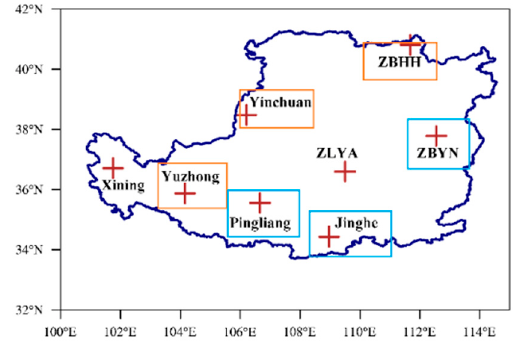
Figure 3. Locations of the eight stations with long time scales (1974–2019) sounding data. Blue boxes indicate the majority area of positive feedbacks, and orange boxes indicate the majority area of negative feedbacks.